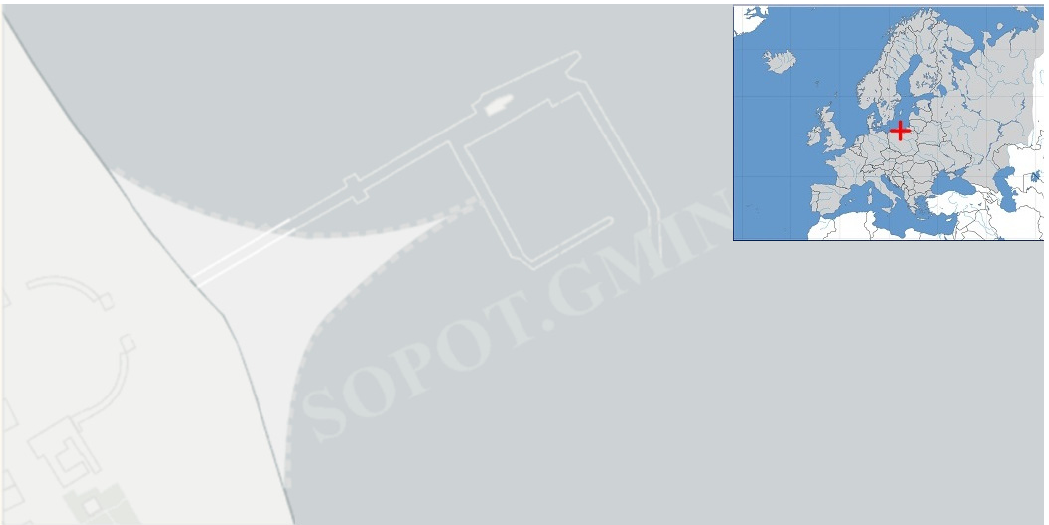
Figure 2. Forecast development model of the tombolo phenomenon in Sopot.